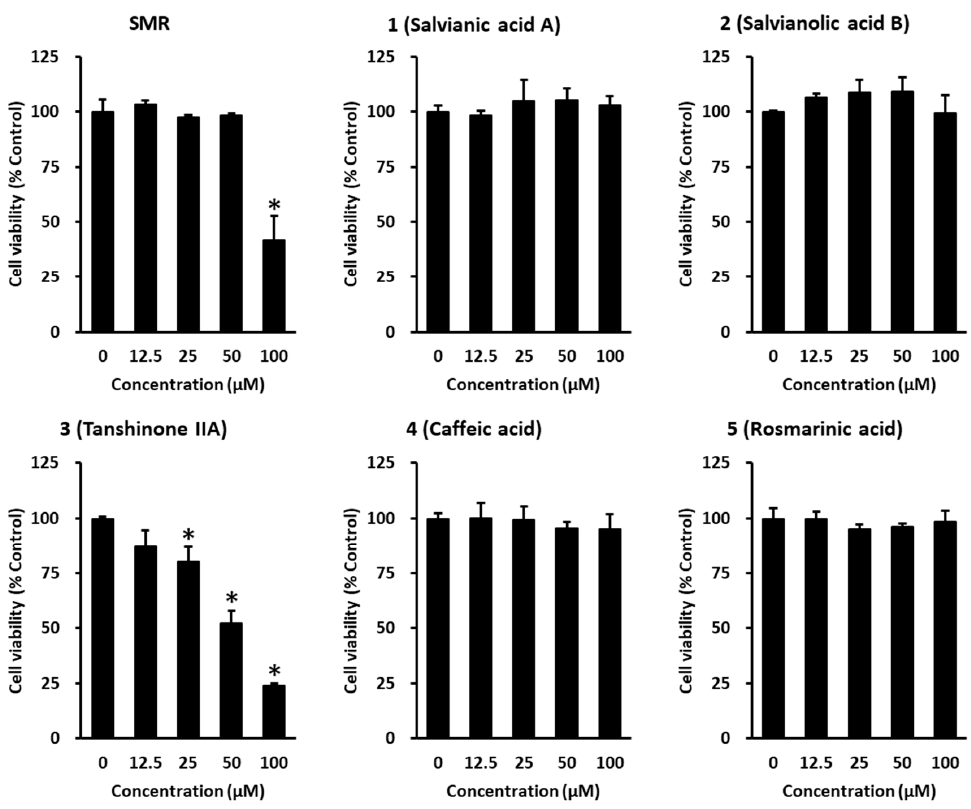
Figure 2. Cytotoxic effect of 70% ethanol extract of Salviae Miltiorrhizae Radix ( SMR ), salvianic acid A ( 1 ), caffeic acid ( 2 ), rosmarinic acid ( 3 ), salvianolic acid B ( 4 ), and tanshinone IIA ( 5 ) on HCT ‐ 116 cells.